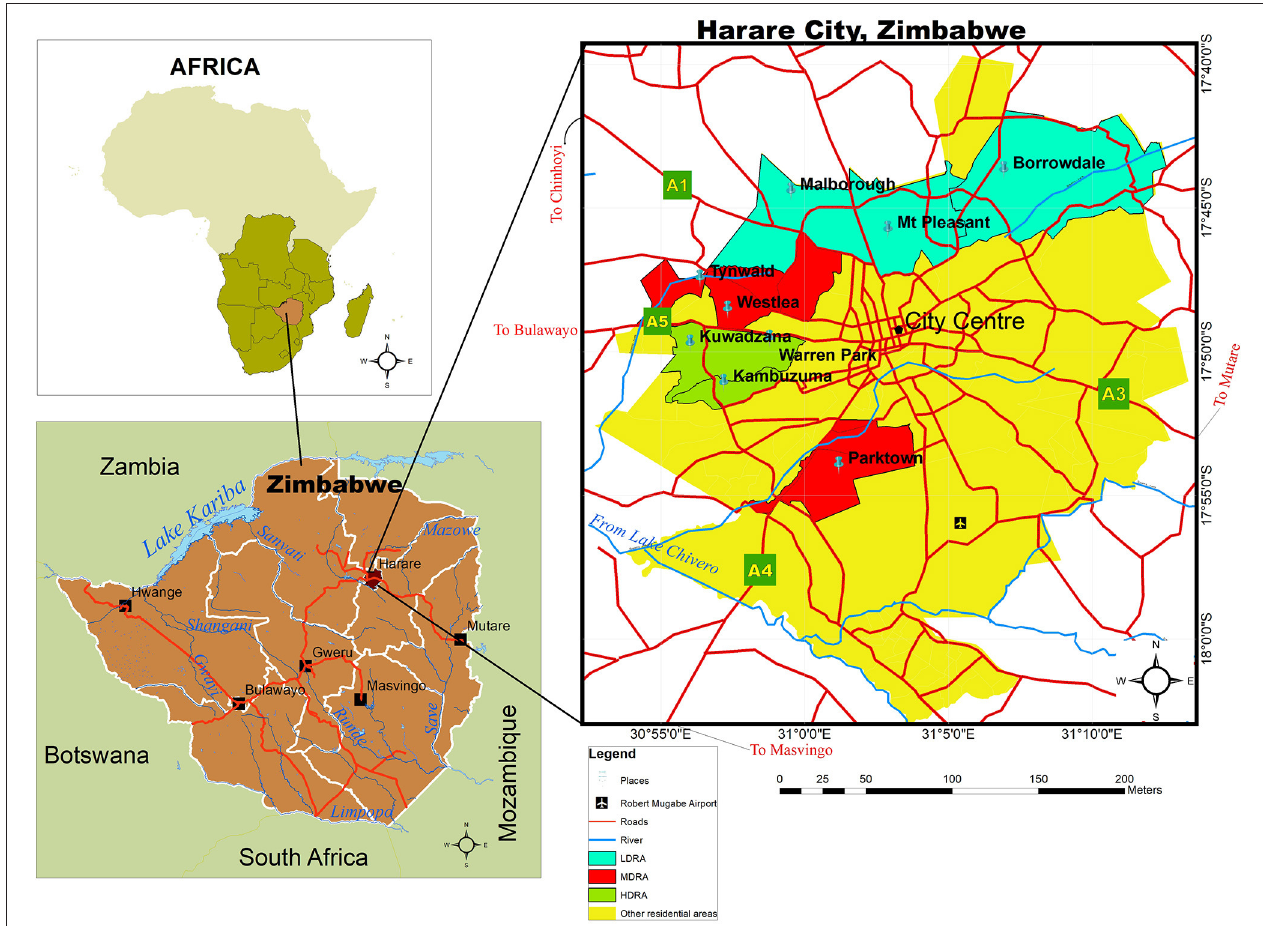
FIGURE 1 | Map of Harare and residential study sites1. Source: Memory Reid.